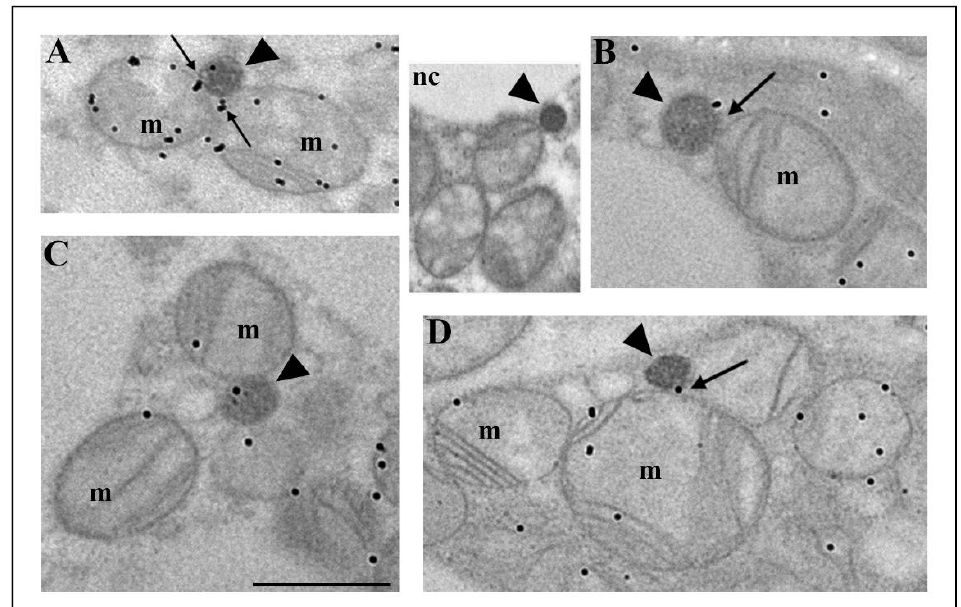
Figure 6. Immunogold labelling of VDAC1, a protein of the mitochondrial outer membrane, in brown adipocytes from both euthyroid and hypothyroid groups. The immunopositive reaction was localized on the mitochondrial outer membrane, on mitochondrial cristae, and on the membrane of some peroxisomes ( A – D , arrowheads). Note the immunopositive reaction on the contact sites of peroxisomes and mitochondria ( A , D —arrows). In addition, we observed peroxisomes that arose by budding from the mitochondrial outer membrane, which was VDAC1 positive ( B –arrow). Inset nc, negative control of immunolabeling. Original magnification 17,000×, scale bar 1 µm.